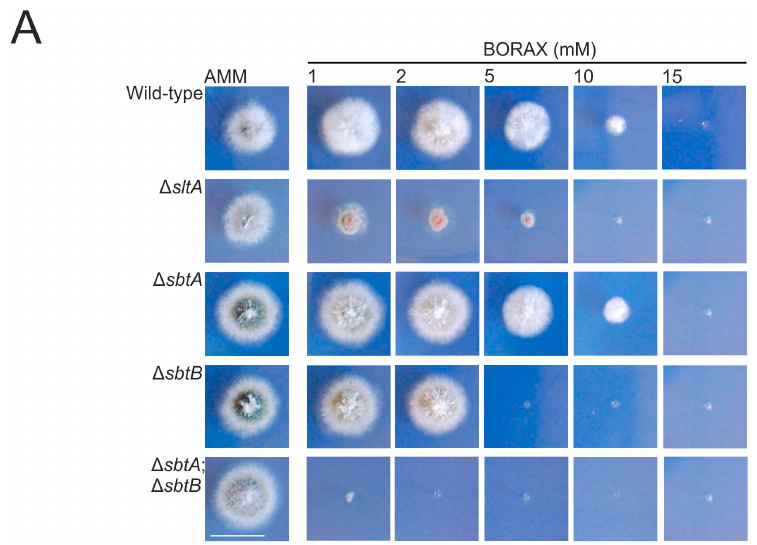
Figure 5. Cont. Figure 5.